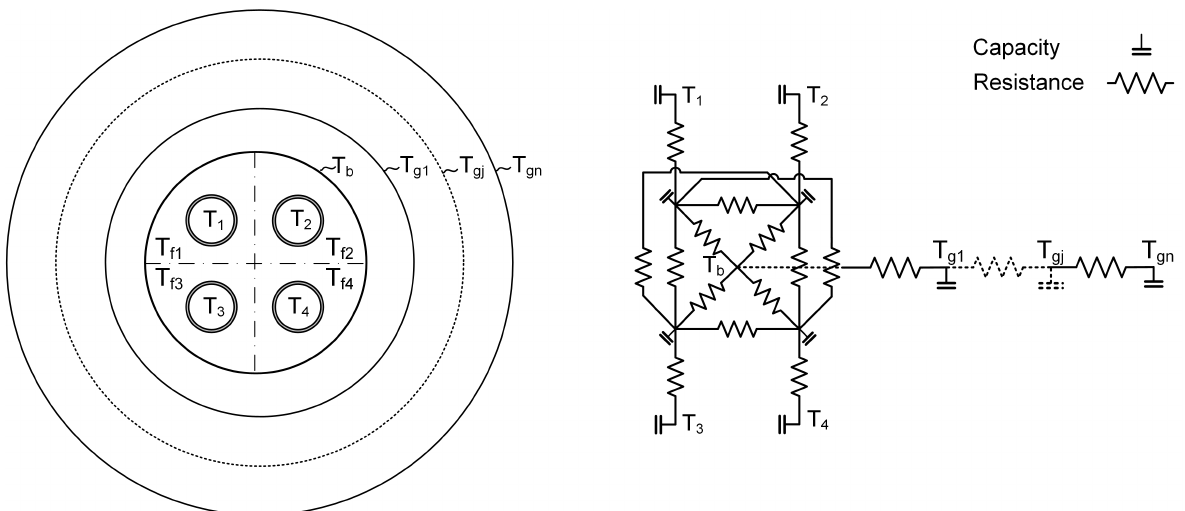
Figure 3. RCM for a segment of a 2U-probe and the surrounding soil with the calculated temperatures: T ... Temperature of the fluid in the pipes. T f ... Temperature of the filling material, T b ... Temperature of the borehole wall, T g ... Temperature of the surrounding ground. Adapted from